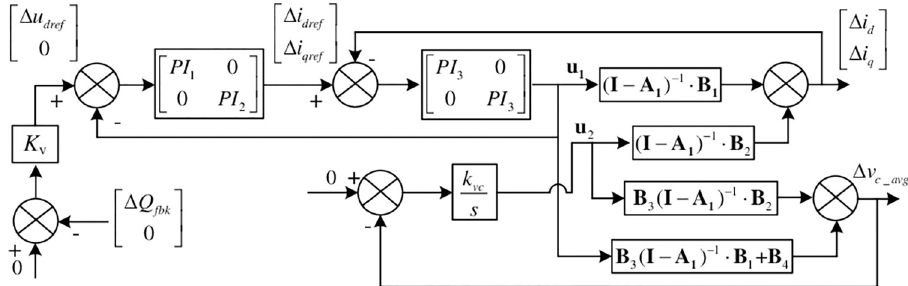
Fig 4. Converter small signal transfer function structure of constant DC voltage